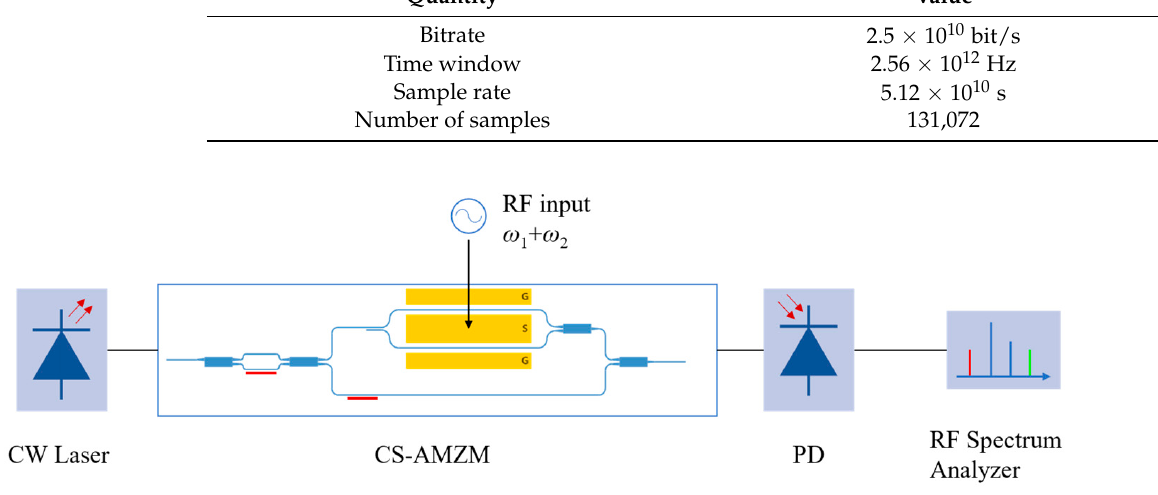
Figure 5. Simulation setup for CS-AMZM testing.